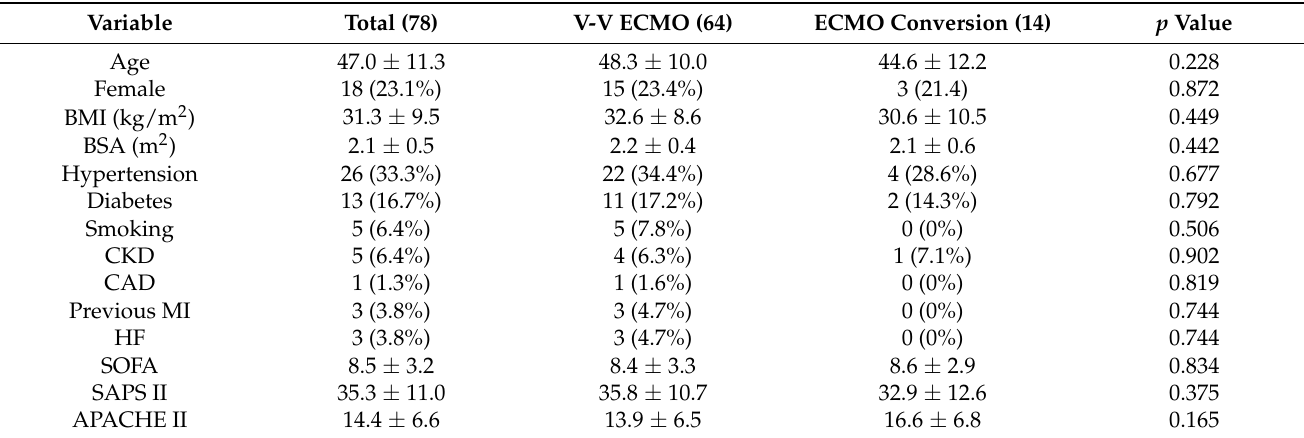
Figure 1. Study flow diagram. ECMO, extracorporeal membrane oxygenation; V, venous; A, arterial; and LTx, lung transplantation. Table 1. Baseline patient characteristics.